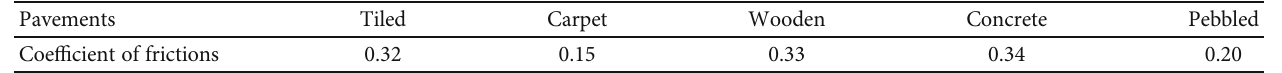
Table 1: Friction coe ffi cients of pavements.